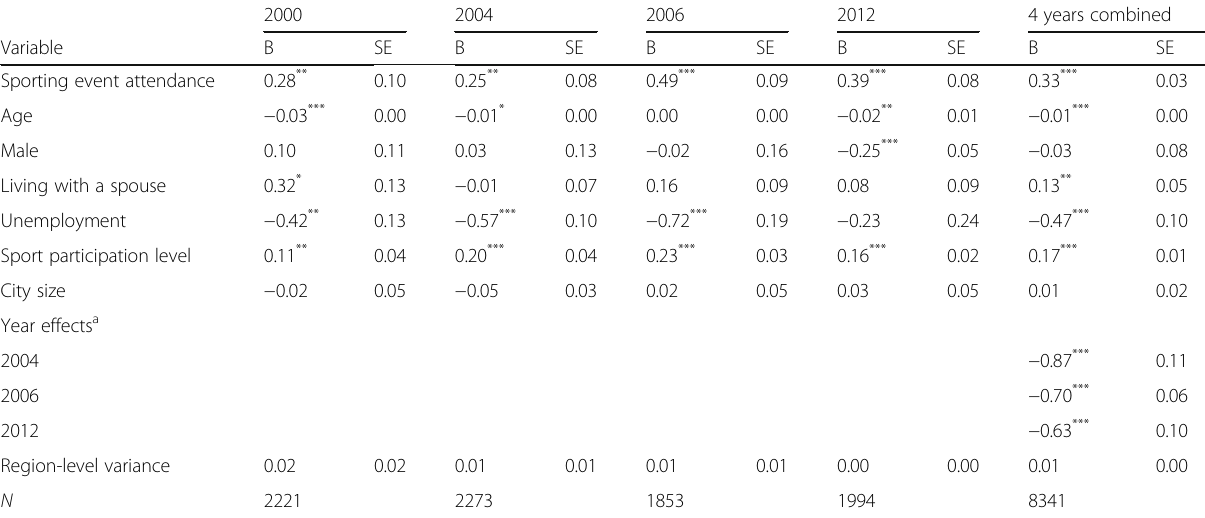
Table 2 Results of Multilevel Ordinal Logistic Regression Analysis Explaining Self-Rated